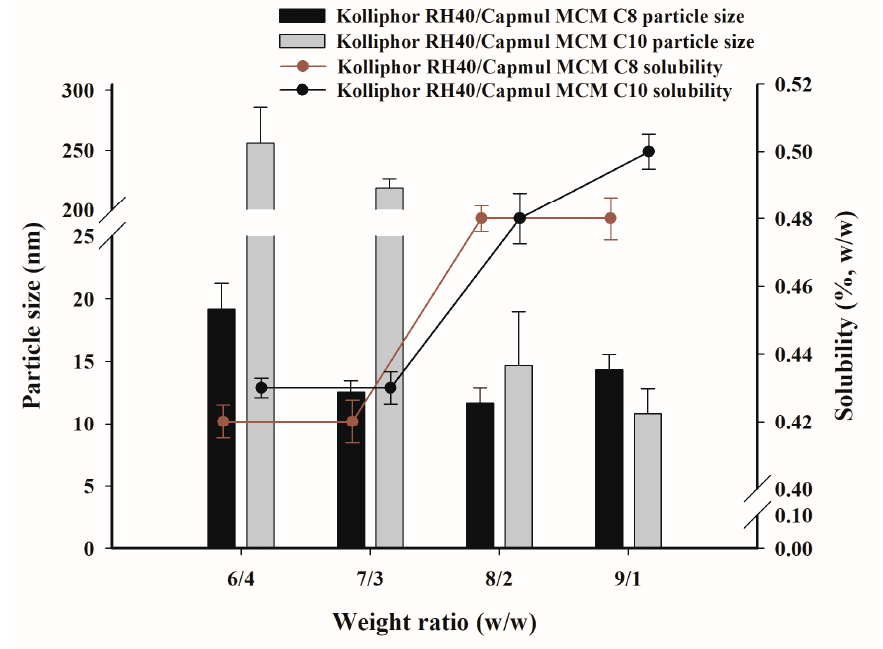
Figure 4. The saturated solubility of PZH in TCV and the particle size dispersed in water.